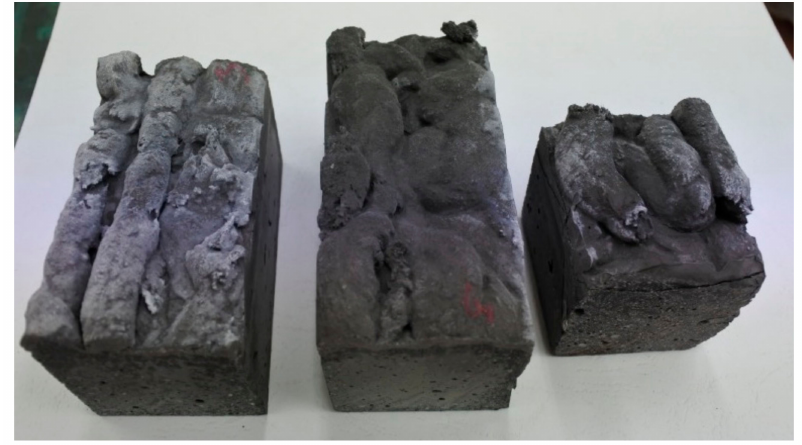
Figure 2. Appearances of the samples made by the injection